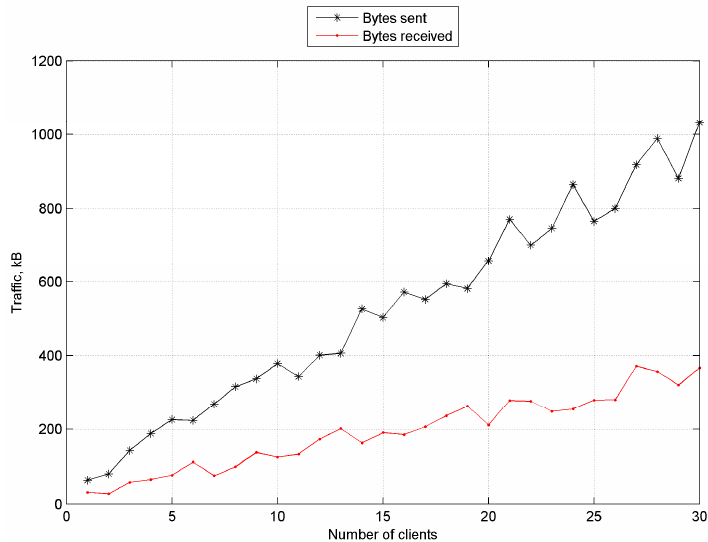
Figure 10. Network bytes sent to and received from a cloud server vs. the number of clients.